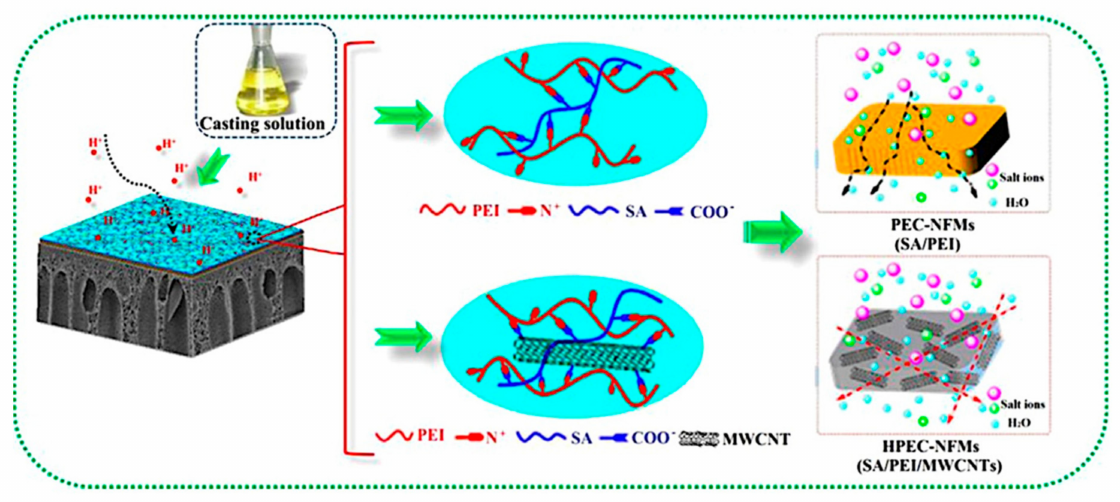
Figure 15. Schematic diagram for the mechanism of in-situ ionic cross-linking of PEC-NFMs and HPEC-NFMs. Reproduced with permission from Reference